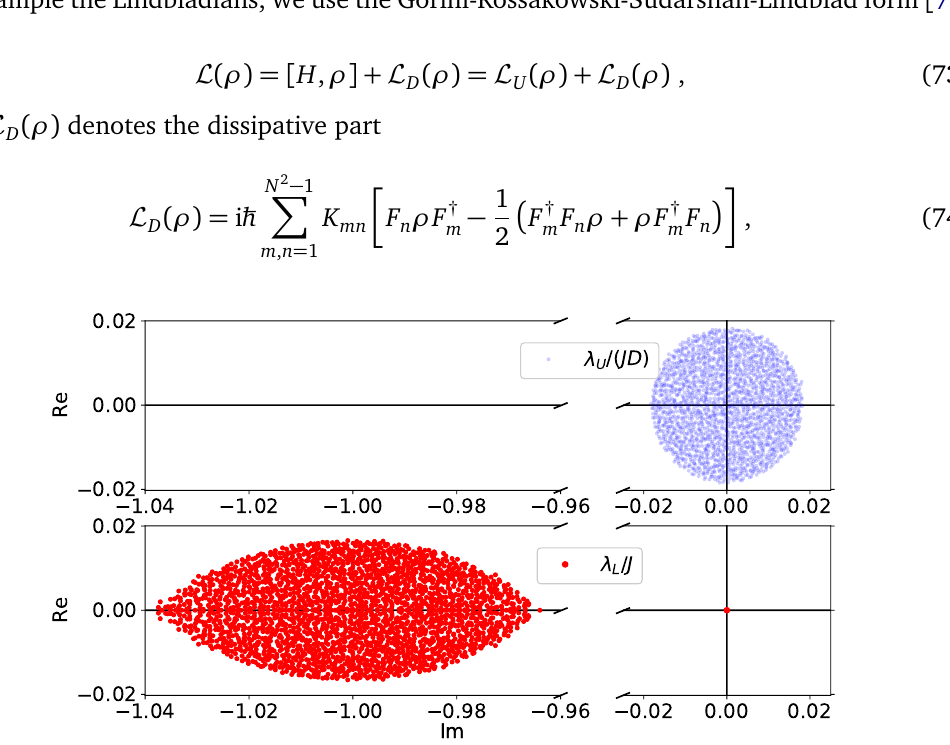
} of a matrix with uniformly random complex Figure 12: Top: Circular spectrum { λ U elements sampled with (62) for α = 0.5 and dimension D = 2000. The spectrum is normalized to the matrix dimension D and energy scale J . Bottom: Spectrum { λ } of a random Lindbladian, see Sec. 4.6.1, normalized to the energy scale J . The L Lindbladian is sampled with N = 50 states, yielding D = N 2 = 2500 eigenvalues. = 0 and a lemon-shaped cluster The spectrum consists of a single stationary state λ L around −